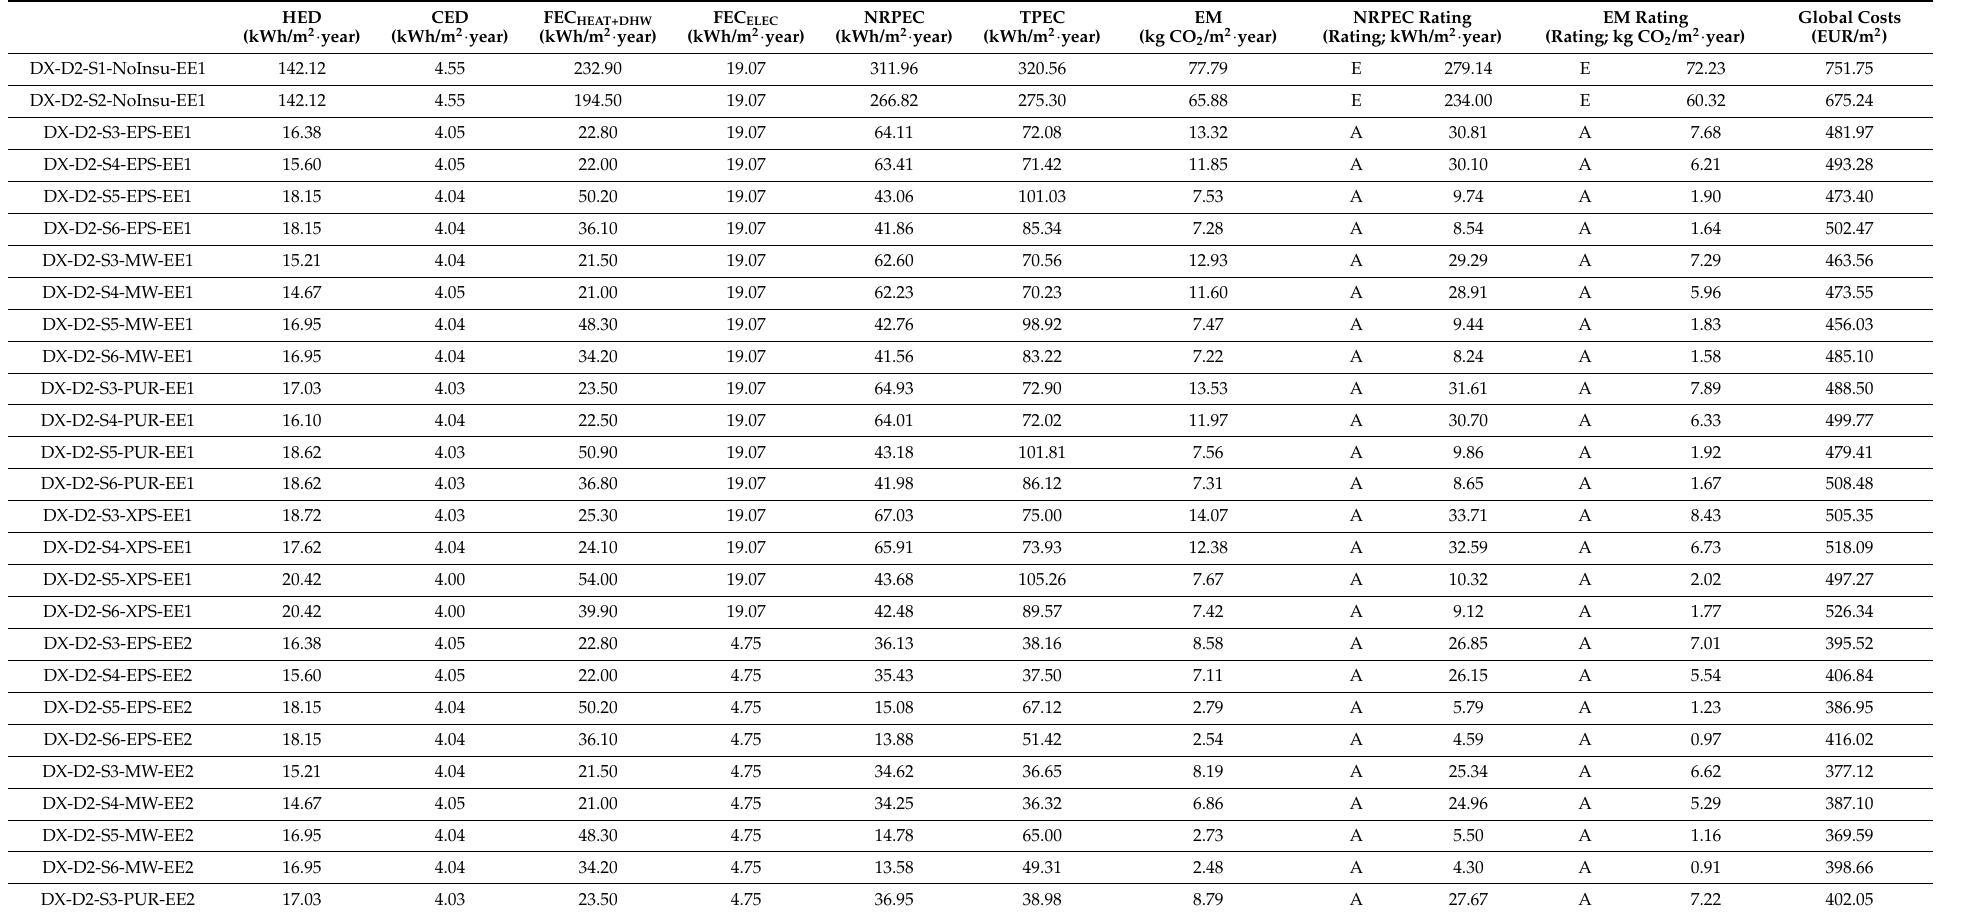
Table 7. Energy, environmental and economic impacts for each case study in Cervera del R í o Alhama (CCZ